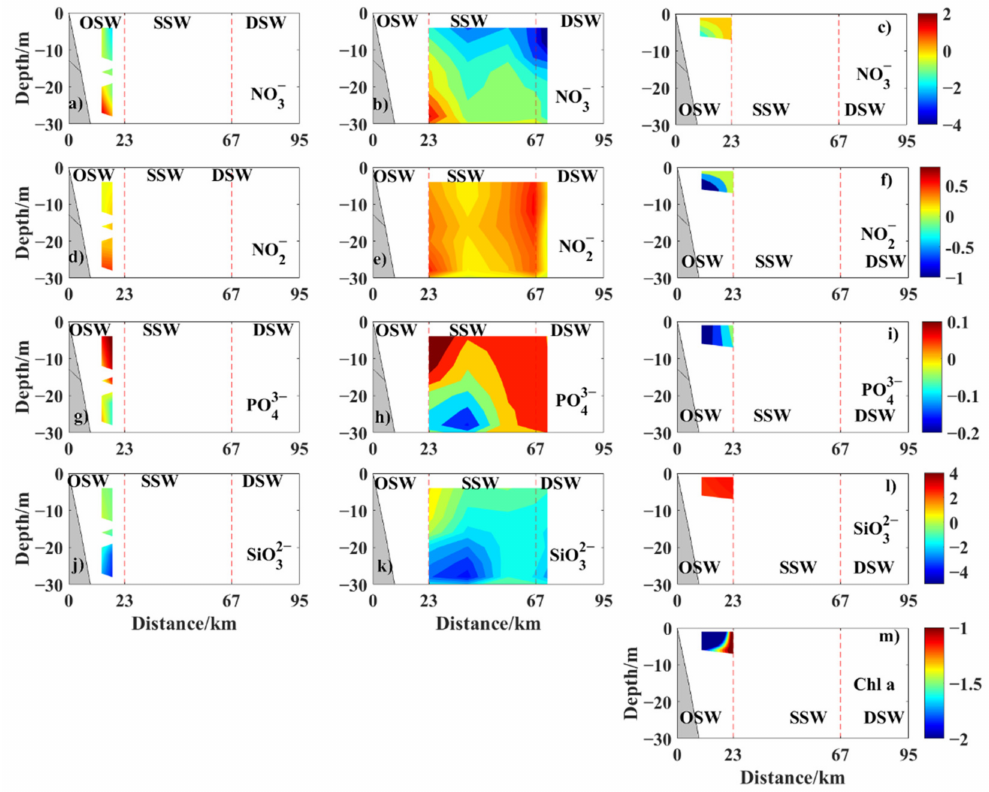
Figure 8. 2D ( x – z ) distributions of variations of nutrient and Chl a concentrations. ( a , d , g , j ) are for before the typhoon–without the typhoon, ( b , e , h , k ) for after the typhoon–without the typhoon, and ( c , f , i , l , m ) for after the typhoon–before the typhoon. Dotted red lines represent positions of 50 m and 120 m